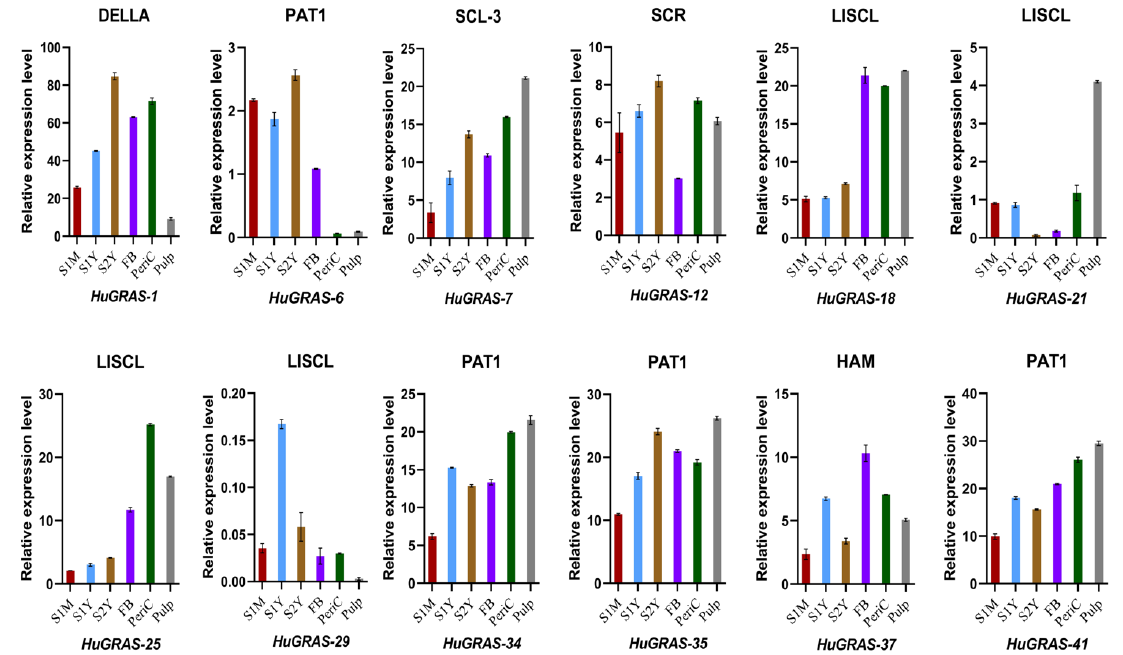
Figure 8. qRT ‐ PCR expression analysis of 12 genes in six tissues of the pitaya ( S. undatus L.) plant. The X ‐ axis represents the plant tissues, including one ‐ month ‐ old stem (S1M), one ‐ year ‐ old stem (S1Y), two ‐ year ‐ old stem (S2Y), flower bud (FB), pericarp (PeriC) and pulp. Error bars represent the standard deviations for the three replicates.